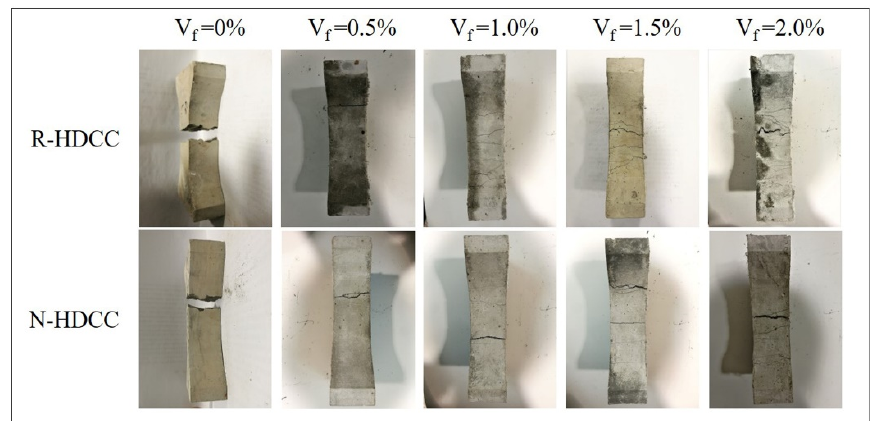
Figure 12. Stress versus strain of R-HDCC and N-HDCC: ( a ) V f = 0, ( b ) V f = 0.5%, ( c ) V f = 1.0%, ( d ) V f = 1.5% and ( e ) V f = 2.0%.